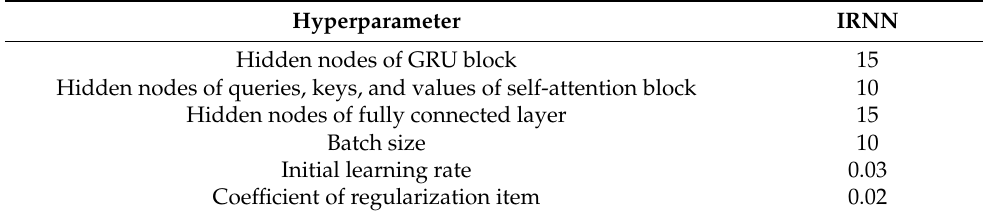
Table 1. The hyperparameters used in